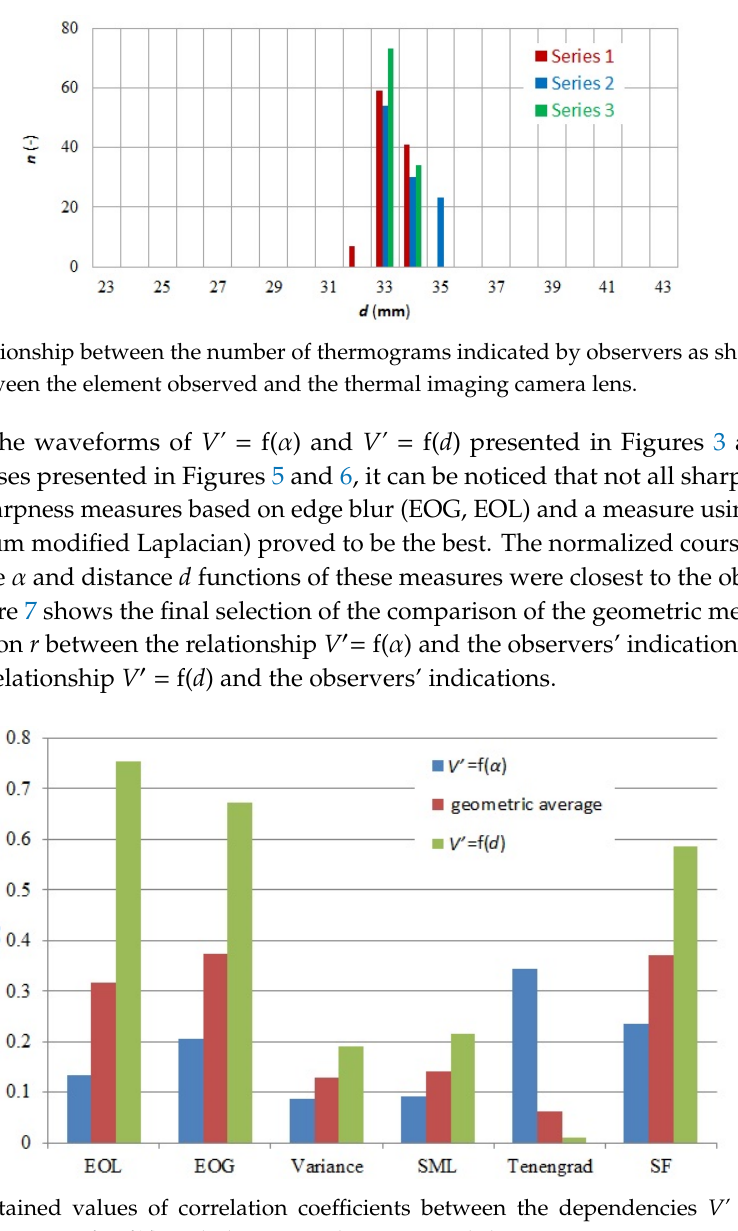
Figure 5. Relationship between the number of thermograms indicated by observers as sharp and the angular position α of the focusing adjustment ring of the thermal imaging camera lens.